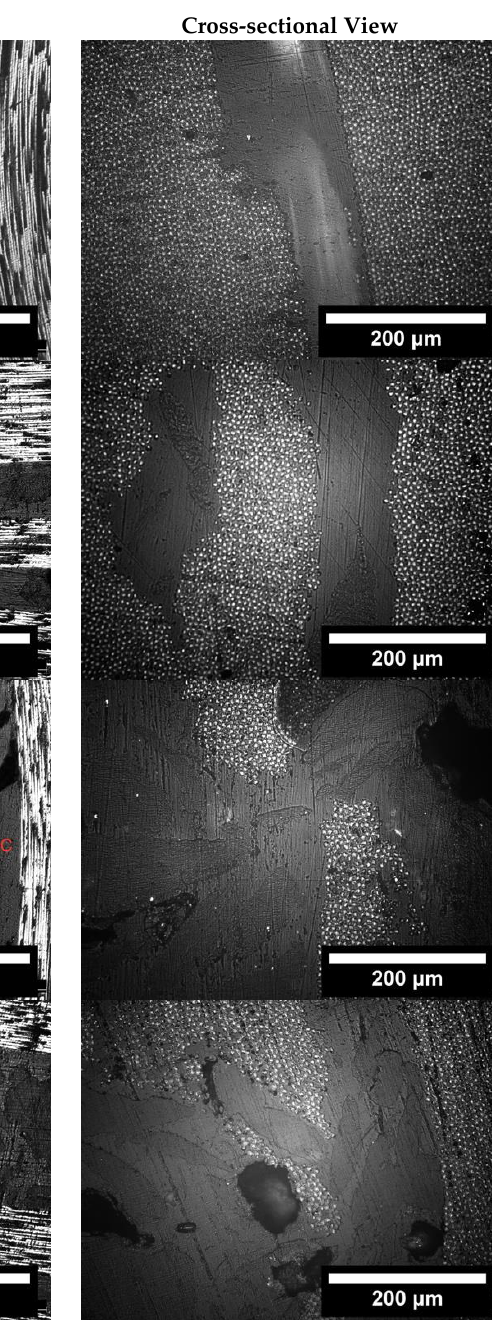
Figure 3. Optical microscope images of epoxy system/carbon fiber (EP/CF) and epoxy system x cyclic olefin copolymers/carbon fiber (EPxCOC/CF) composites (x = 10–30 wt.%).